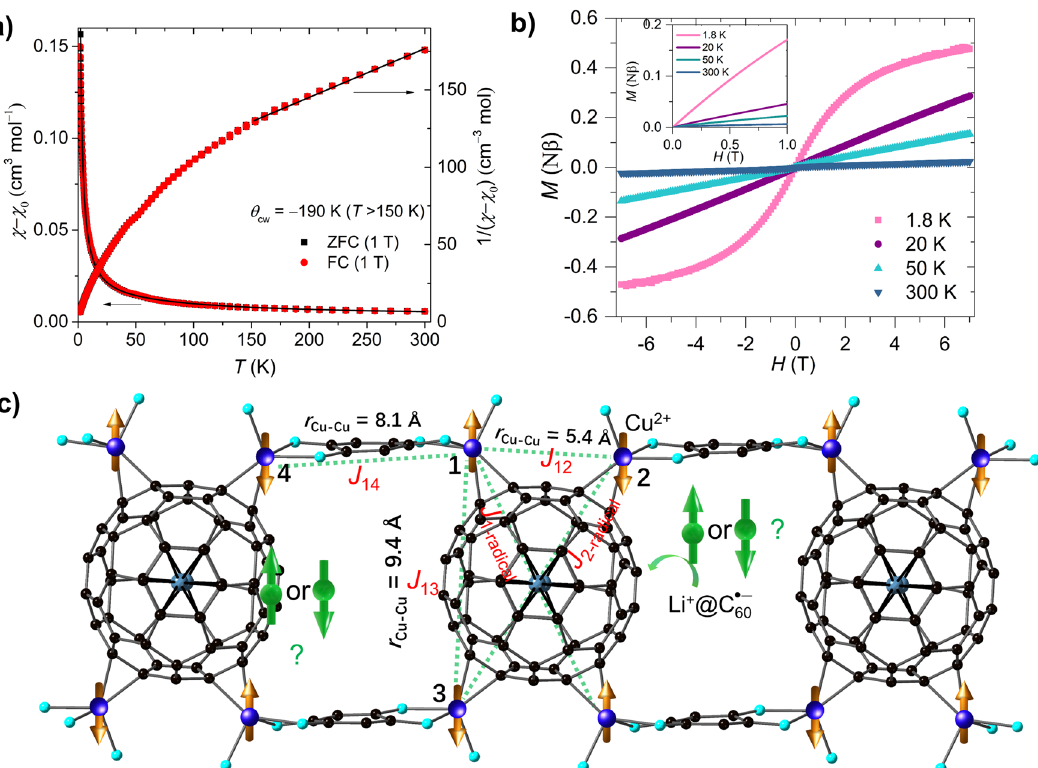
Fig. 4 Magnetic properties. a The temperature dependence of magnetic susceptibility product ( χ − χ 0 ) of 1 in FC, ZFC modes and the corresponding ( χ − χ 0 ) − 1 ‒ T plots under a 1 T fi eld from 1.8 to 300 K. The black curve represents the best fi t for ( χ − χ 0 ) by considering the possible exchange interaction between spins. The black line represents the best fi t by the Curie ‒ Weiss law. A large negative θ cw = − 190 K is observed, suggesting strong AF exchange interactions. b Magnetic- fi eld dependence of magnetisation of 1 at 1.8, 20, 50, and 300 K. There is no hysteresis loop at these temperatures. c Spin orientations of the Cu 2 + ions and Li + @C 60 (cid:129) − superatoms emerging in the 1D ladder-like magnetic chain; the four Cu ions and Li + @C 60 (cid:129) − superatoms are aligned in a triangular-like lattice and antiferromagnetically interact with each